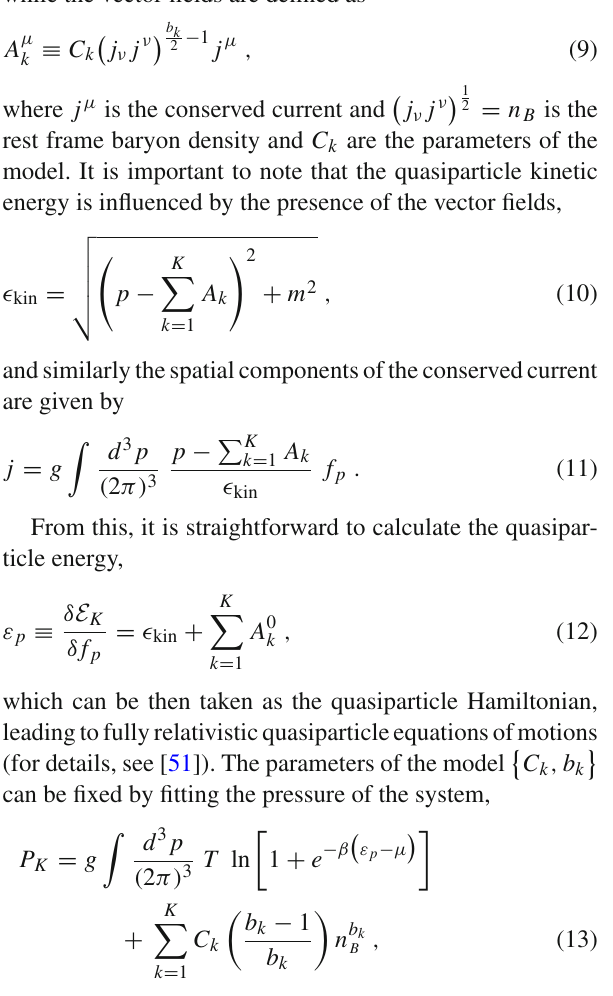
n L and n R , are not used to fit the parameters, but rather are proper- ties of the EoSs resulting from fitting to the chosen set of character- ( N ) , T ( N ) , n ( Q ) , T ( Q ) , η , η } . Parameters of the istics { n 0 , E 0 , n L R c c c c VDF model leading to the above sets of characteristics are listed in Appendix